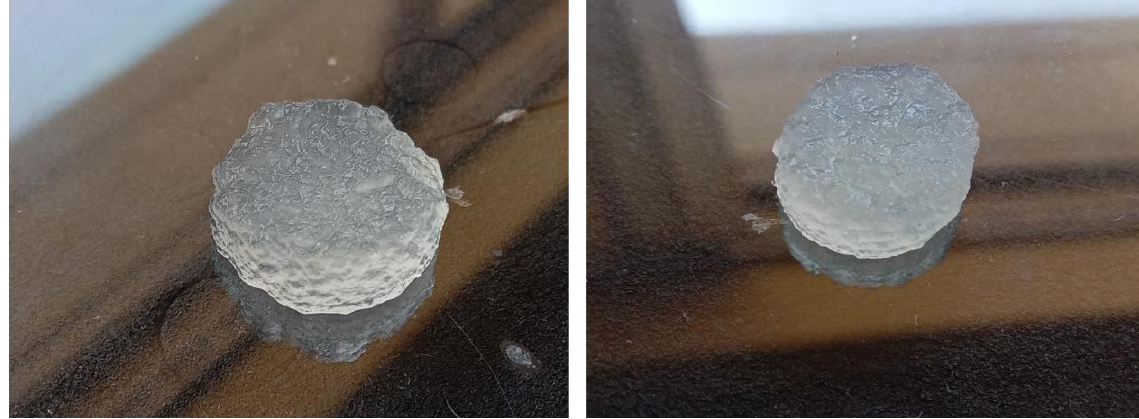
Figure 10. Three-dimensional printed sodium alginate gel cylinders prior to crosslinking.